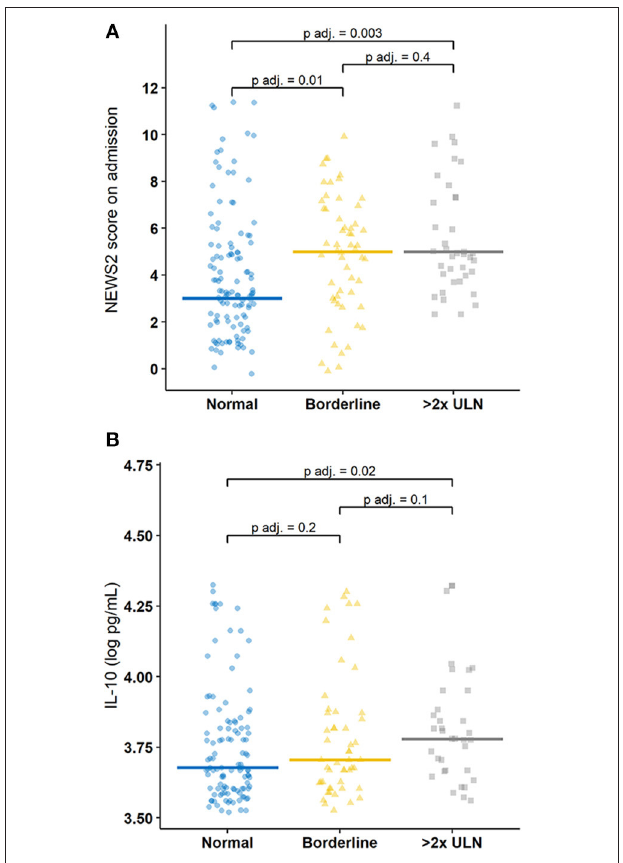
FIGURE 2 | Jitter plot of the distribution of (A) NEWS2 score on hospital admission and (B) IL-10 (log pg/ml) measurements according to the liver transaminase